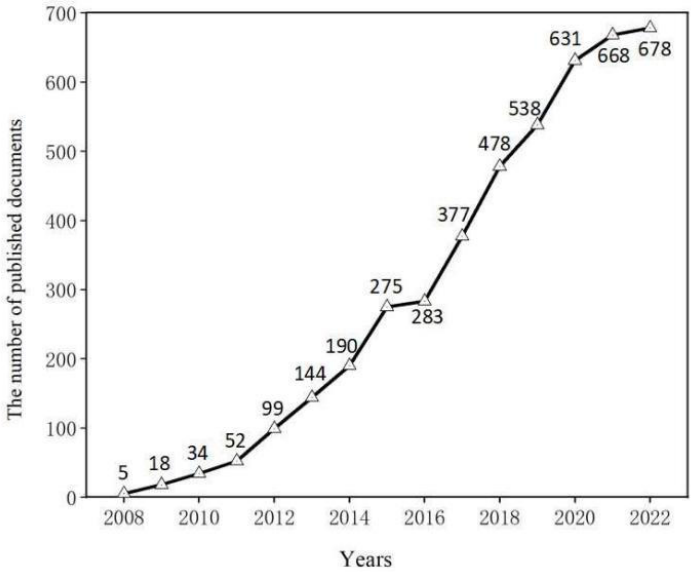
Figure 1. The number of published papers about metamaterial absorber from 2008 to 2022.